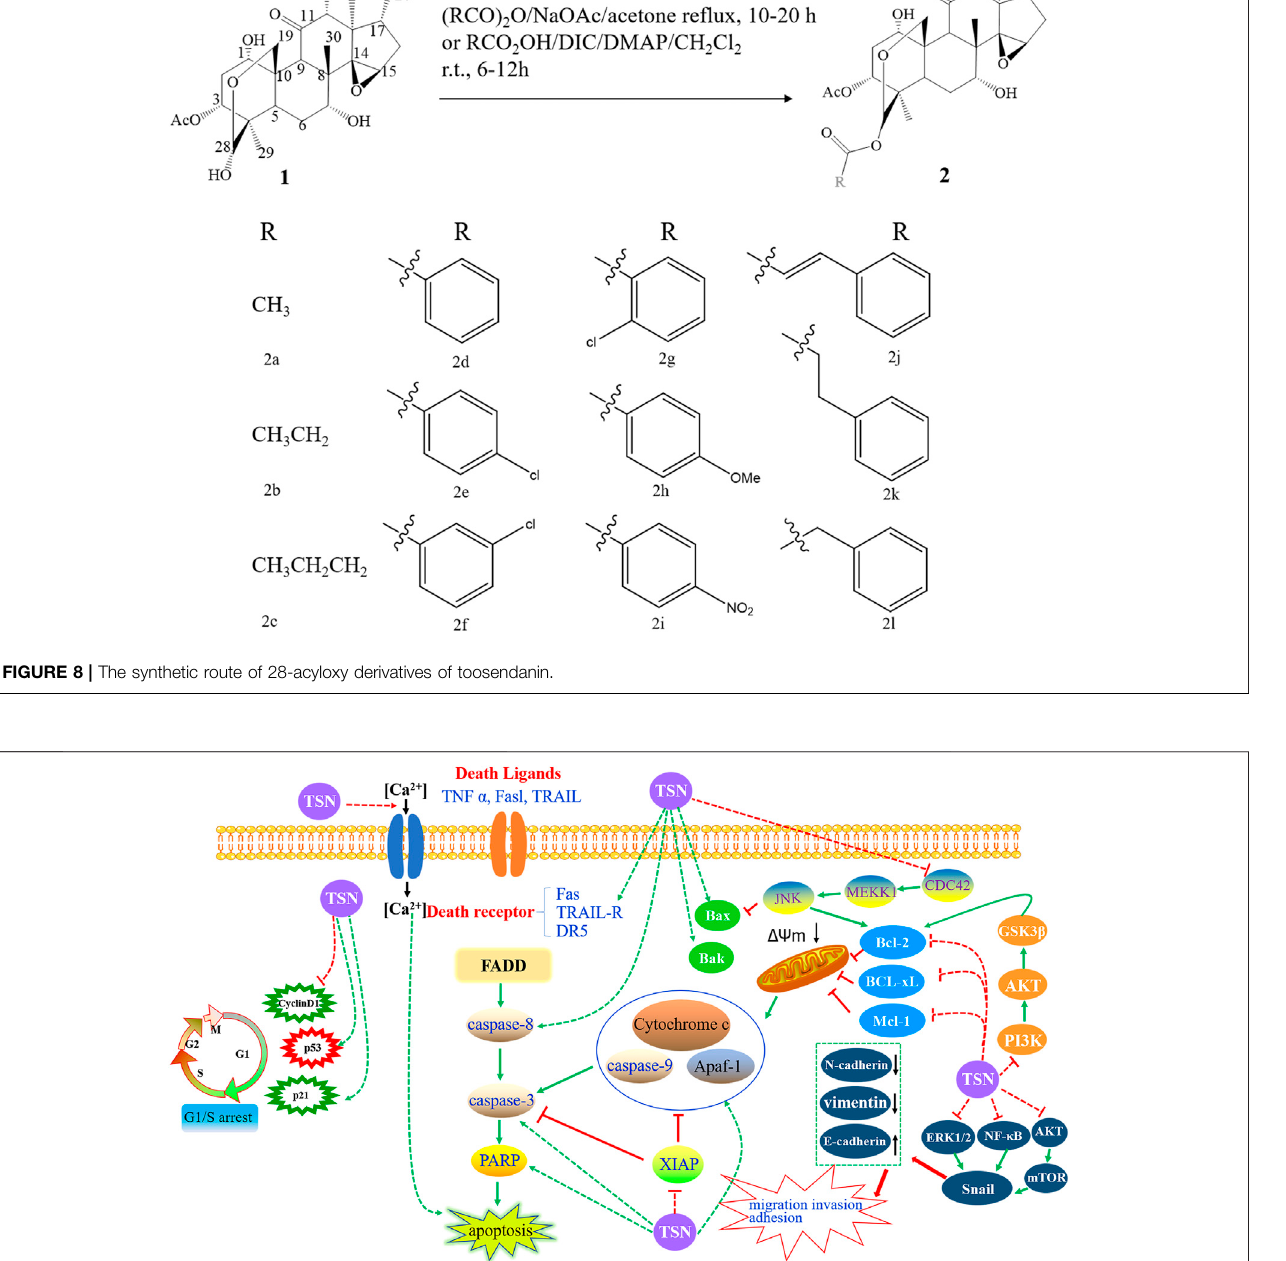
Frontiers in Pharmacology |